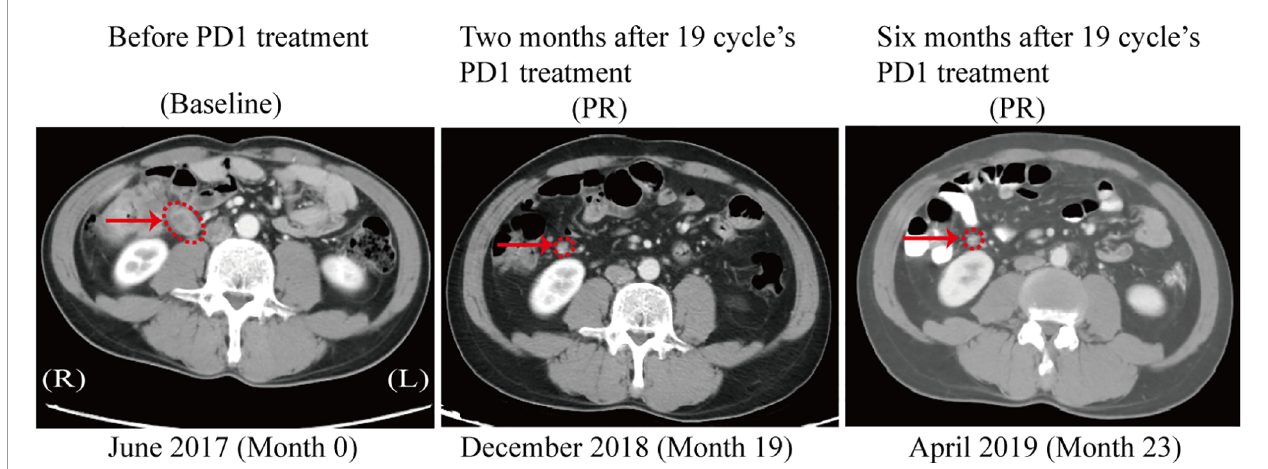
FIGURE 4 | CT scan after PD1 treatment in the patient with MSH2 cytoplasmic staining. A computed tomography (CT) scan revealed the clinical bene fi ts of the PD- 1 inhibitor pembrolizumab in the patient with cytoplasmic staining of MSH2. In June 2017, a baseline CT scan showed an enlarged retroperitoneal lymph node (1.8x2.0 cm) with a diagnosis of metastatic colon cancer (arrows). No disease progression was con fi rmed in this patient 6 months after completion of 19 cycles of immunotherapy, as demonstrated by a stable lymph node size of 0.8x0.8 cm between December 2018 and April 2019